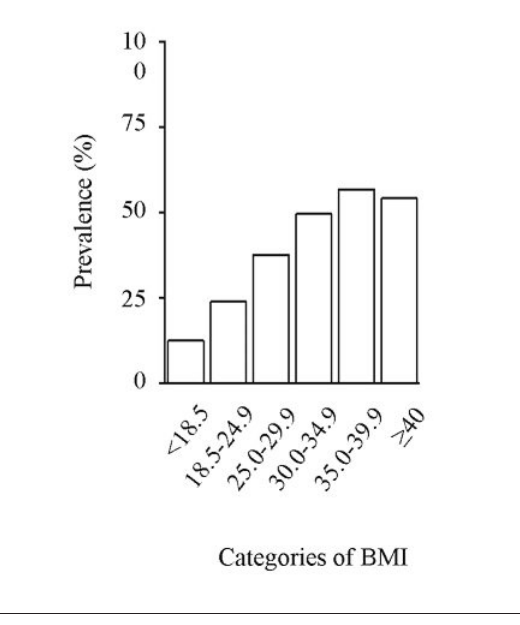
Body mass index, hypertension, and serum cholesterol. NW, no HT denotes the group with nor- mal weight that does not have hyperten- sion, NW, HT denotes